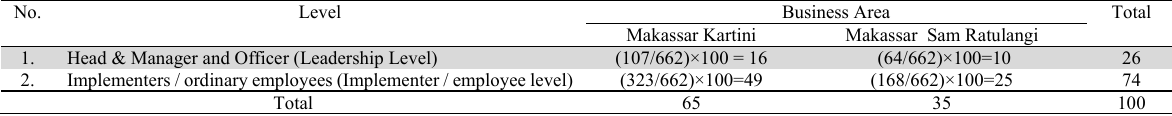
Outher Loadings (Mean, STDEV, T-Value) Labor market opportunities